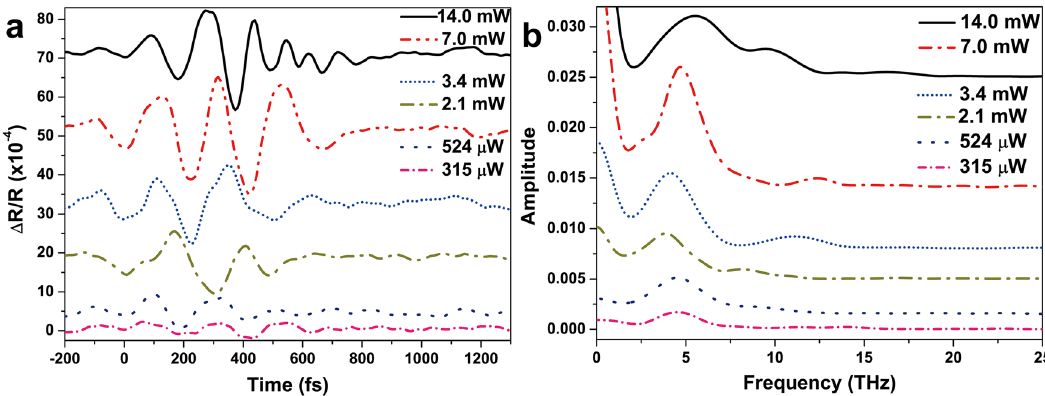
Fig. 2 Transient differential re fl ectivity of colloidal quantum dots (CQDs) on SU8/Si with femtosecond pump pulse at wavelength 710 nm. a Transient differential re fl ectivity ( Δ R/R) and b corresponding fast Fourier transform (FFT) spectra under 710 nm pump with various powers (315 μ W, 524 μ W etc.). Different pump power is denoted by different line pattern. Acronyms of fs and THz are the same as those de fi ned as in the caption of Fig.